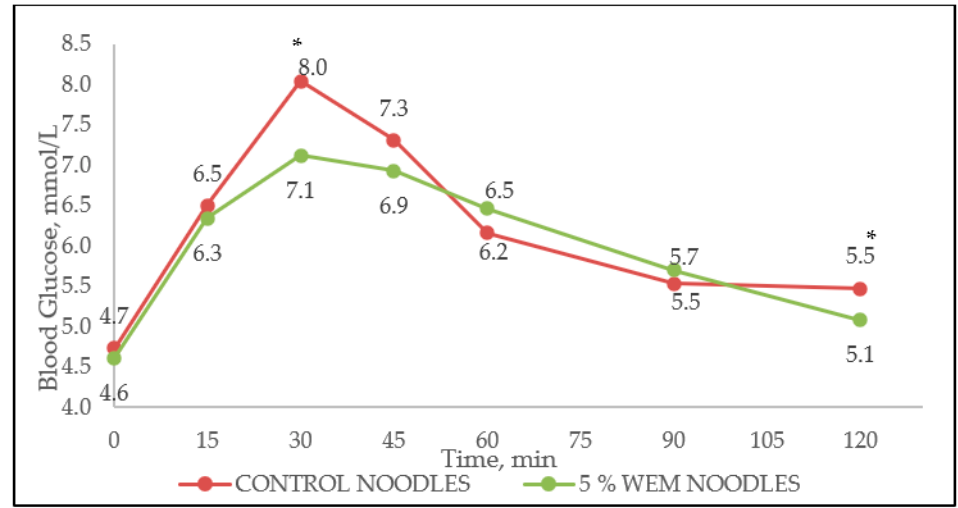
Figure 2. The comparison of postprandial blood glucose response within 120 min between control and 5% WEM instant noodles ( n = 10), * indicates a significant difference ( p < 0.05).